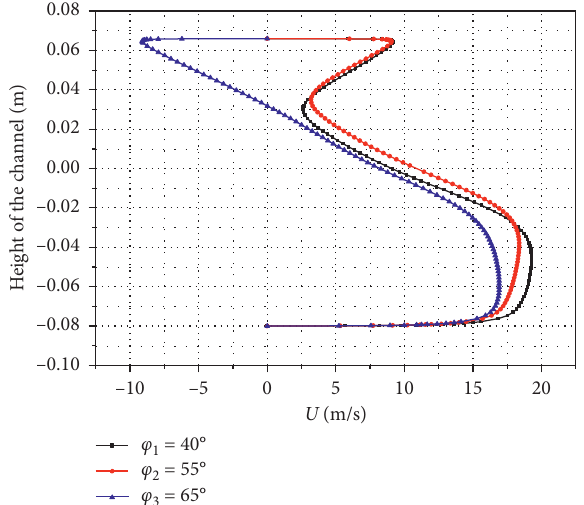
Figure 8: Axial velocity profiles upstream of the second baffle at x � 0.315m for different values of inclination angles: φ 1 � 40 ° ; φ 2 � 55 ° ; φ 3 � 65 ° .